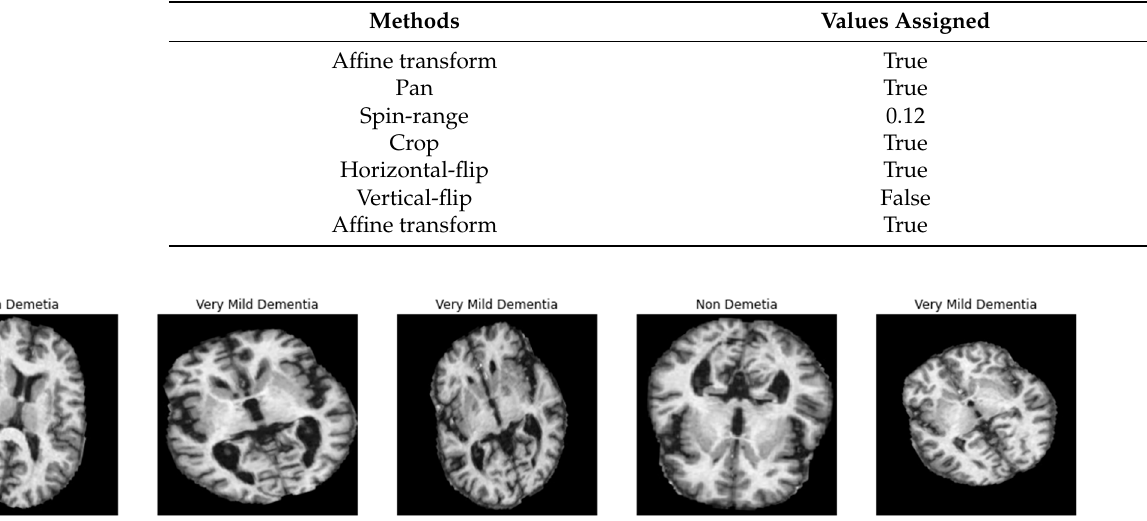
Table 2. Utilized data augmentation techniques to make data balanced.